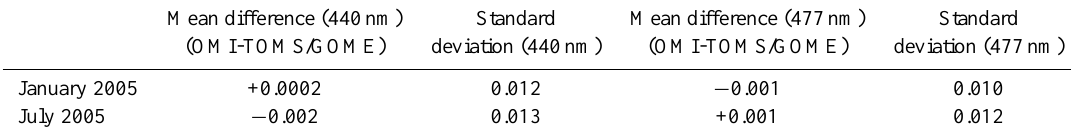
Table 4. Comparison of OMI and TOMS/GOME surface albedo